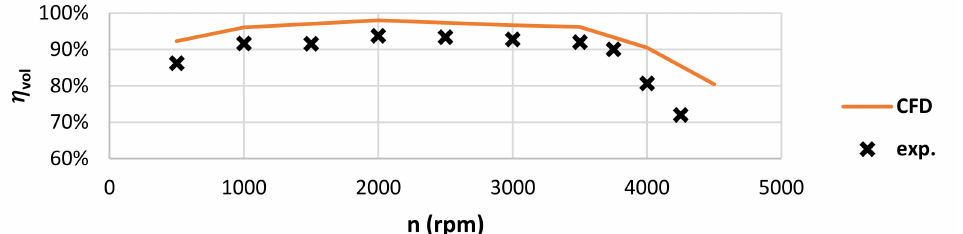
Figure 17. Volumetric efficiencies obtained from the CFD simulation and from the experiment for the TMC pump at 15 bar pressure load and 20 ◦ C oil